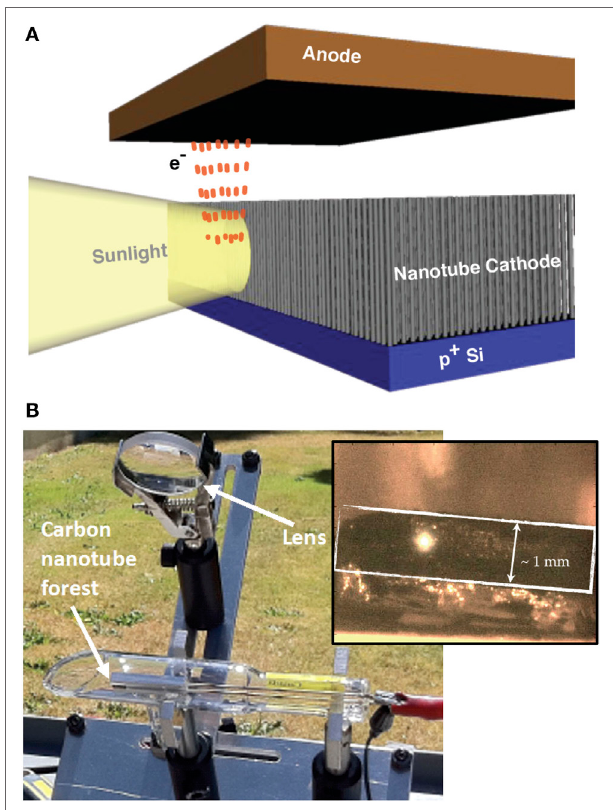
FigURe 3 | (A) Schematic representation of a solar electron source (not to scale). The focused sunlight induces localized heating of the nanotube forest to thermionic emission temperatures, and the anode, placed above the forest, collects the emitted electrons. Due to the “Heat Trap” effect in carbon nanotube forests, it is very easy to locally heat these conducting materials to thermionic emission temperatures using low optical powers. (B) This has enabled the recent demonstration of compact solar thermionic devices. The photograph shows the experimental setup of a solar electron source outdoors. An off-the-shelf, 50-mm-diameter lens was used to concentrate sunlight onto a ~700-µm spot on the side surface of the carbon nanotube forest (placed inside the glass vacuum tube). A Keithly 6517A electrometer was used to apply a collection voltage and measure the electron emission current (inset shows incandescence from a localized hot spot on a nanotube forest, while the surrounding areas of the forest remain cool). Adapted from Yaghoobi et al. (2012) under Creative Commons Attribution